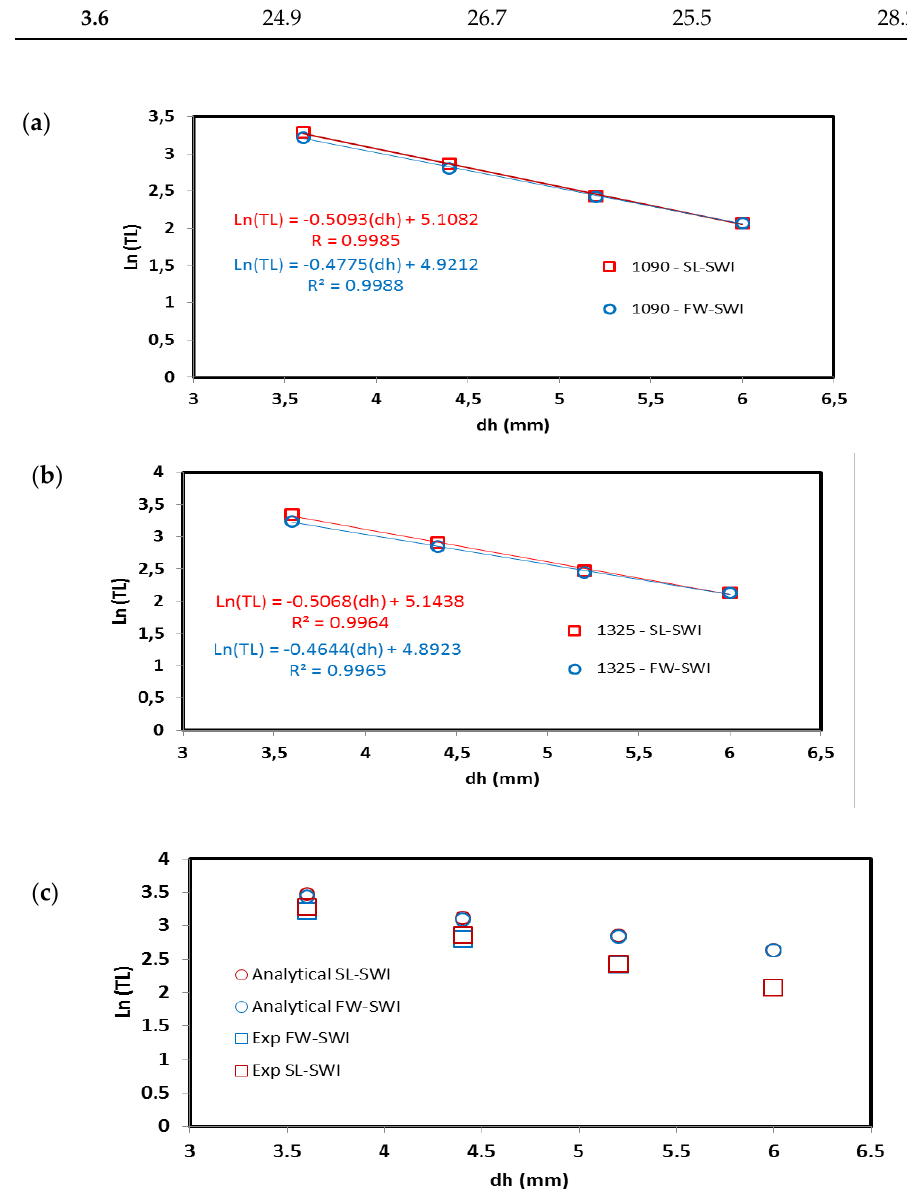
Figure 4. Steady-state to steady-state toe length data against the head difference dh in advancing condition for FW and SL scenarios; ( a ) case 1090 and ( b ) case 1325; ( c ) comparison with the analytical solution (for case 1090).